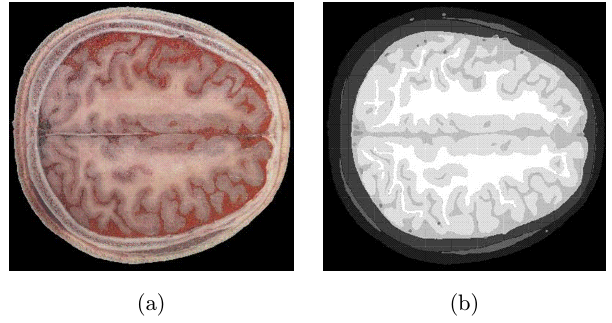
Fig. 1. VCH head model. (a) Digital color photograph of one sliceinthe VCHheaddataset;(b)Segmentationofthe